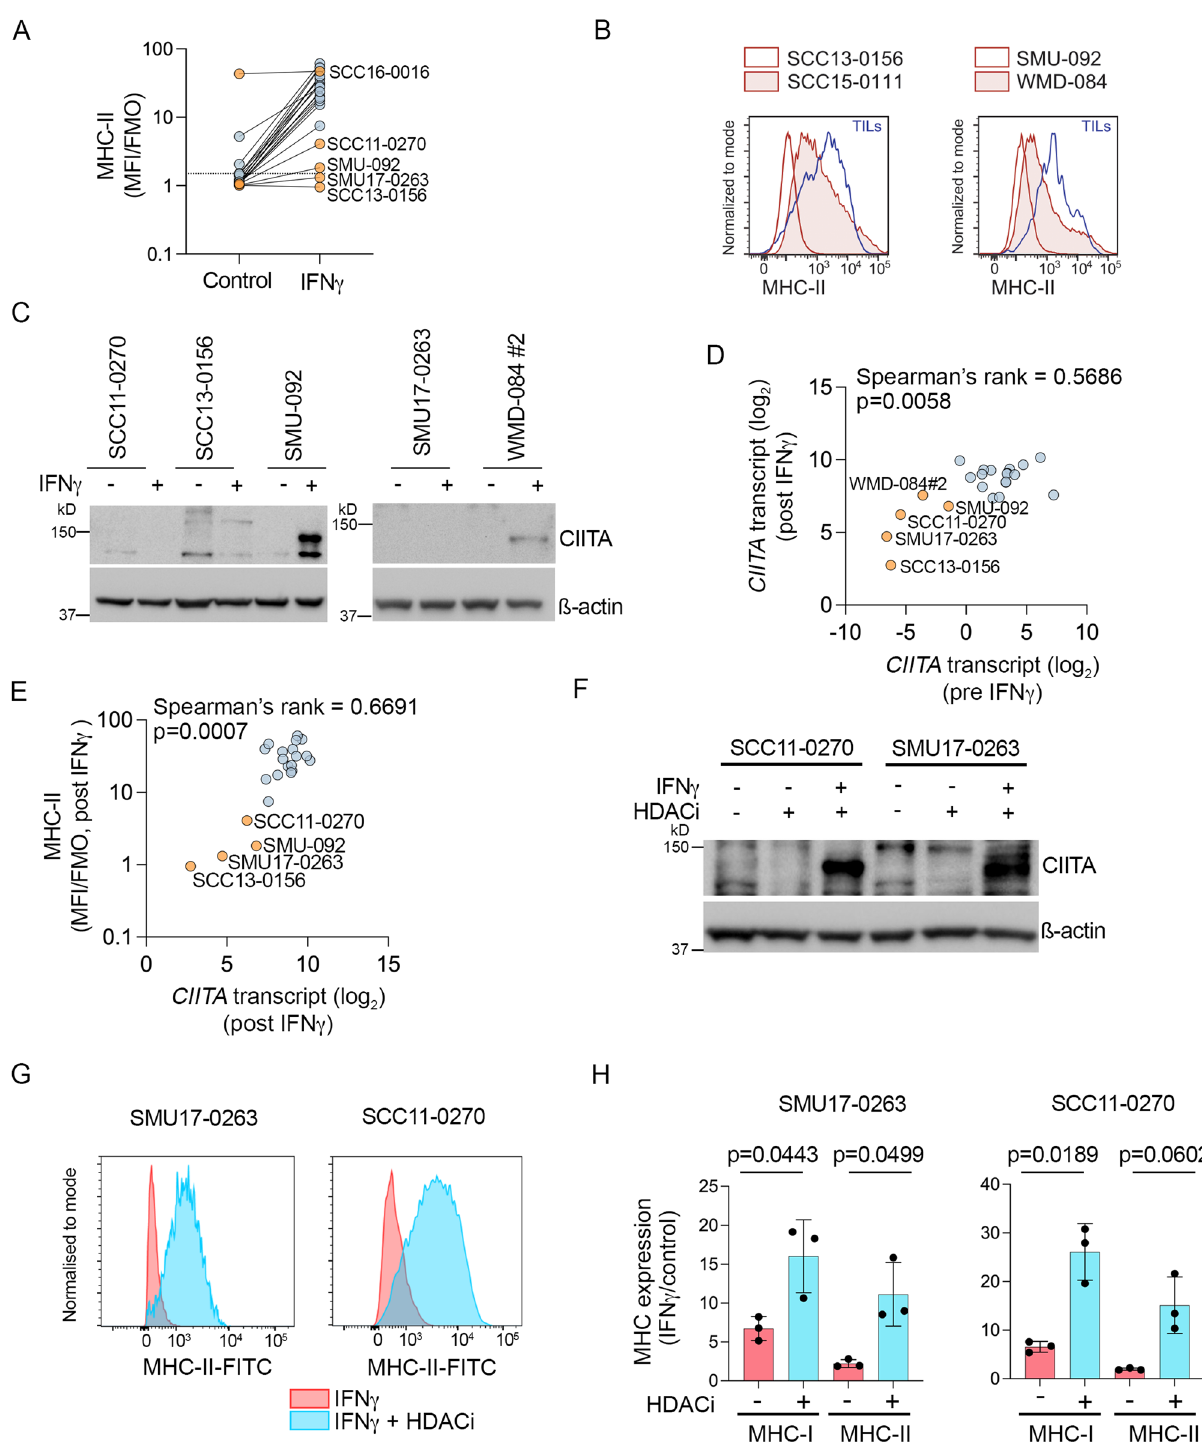
serum (Sigma), 4 mM glutamine (Sigma), and 20 mM HEPES (Sigma)